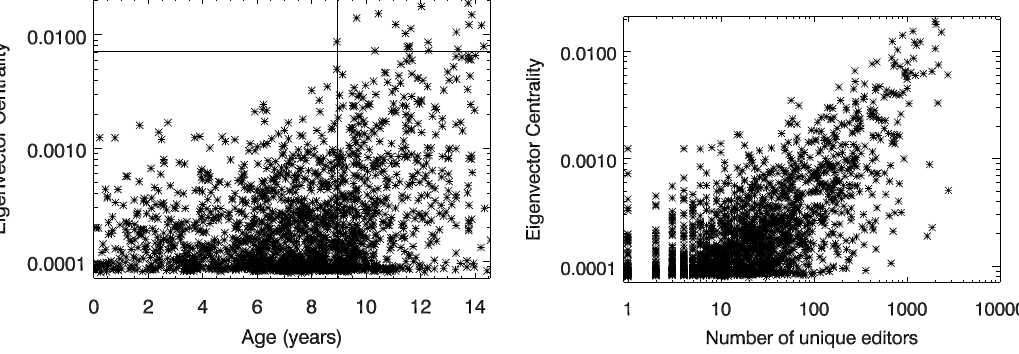
Figure C.1. Important pages are old, but not all old pages are important. Left panel: page age (from the end of our data, in August 2015) vs. eigenvector centrality; “core norms” (top twenty pages by EC) are marked by a lower bound in EC and a lower bound in age. While the very top pages in the hierarchy are all old (in the top-right region), there are many old pages that have eigenvector centrality comparable to much younger pages. Right panel: number of (unique) editors on the page vs. eigenvector centrality. A much tighter correlation shows that pages that attract many unique editors have higher EC. When both effects are taken into account in a simple linear regression model, the number of editors